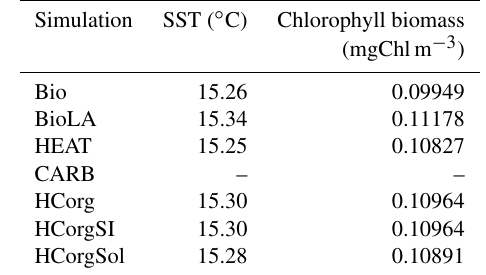
Table 1. Sea surface temperature ( ◦ C) and surface chlorophyll biomass (mgChlm − 3 ). There is no value for the simulation CARB because we run the model with an uncoupled ocean–atmosphere